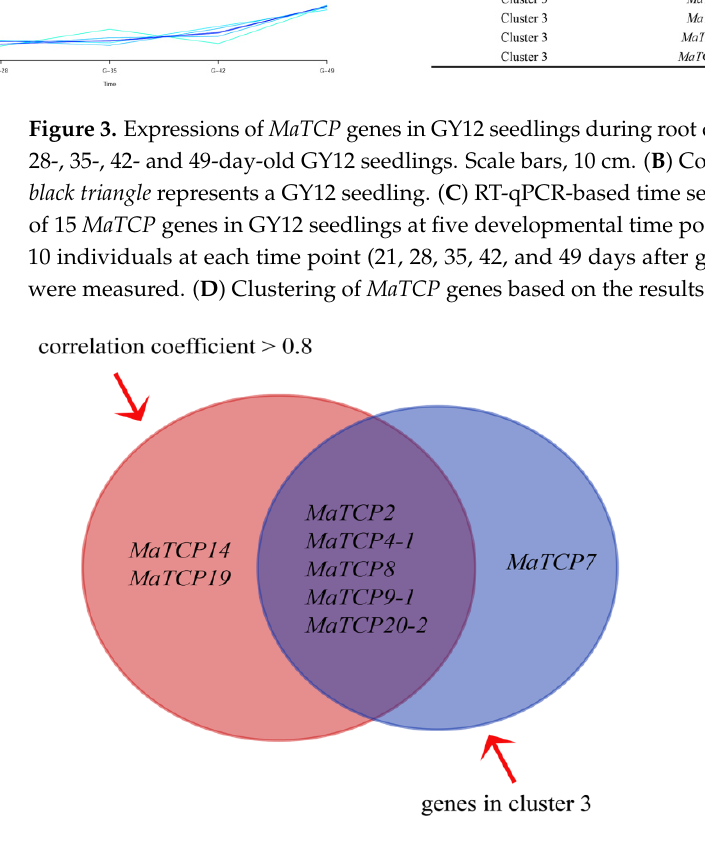
Figure 4. Venn diagram of MaTCP genes significantly associated with root length in a correlation analysis (red circle) and those exhibiting a similar trend in regard to root development in a time series analysis (blue